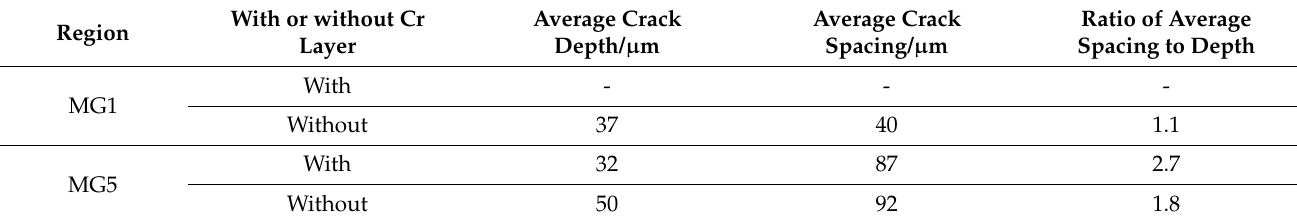
Table 2. Experimental values of crack depth and spacing in a cross-sectional matrix.